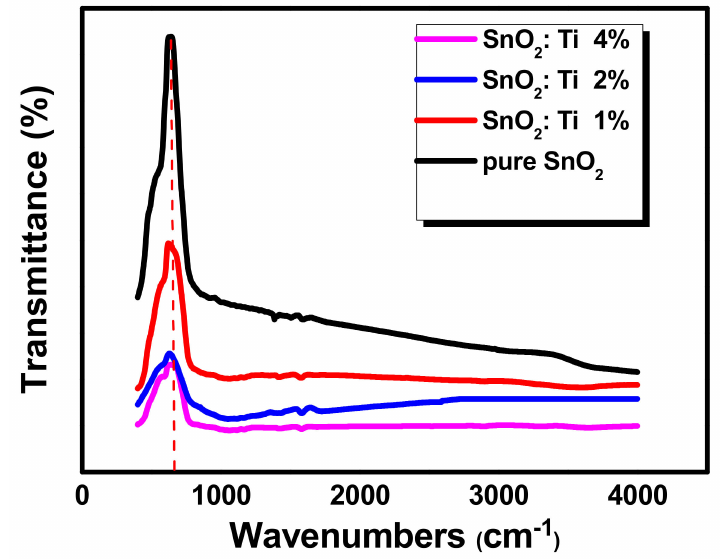
Figure 7. FTIR spectra of Ti-SnO 2